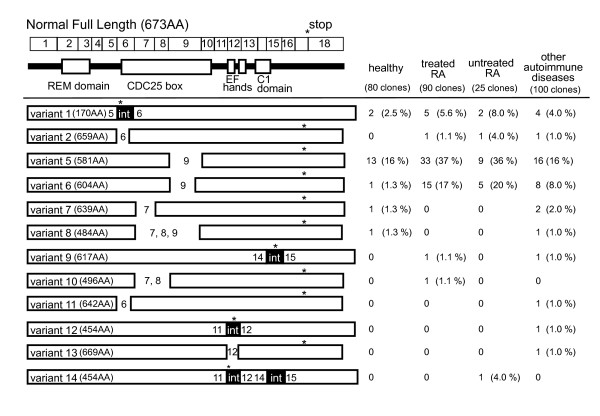
Novel transcripts that encode abnormal hRasGRP4 isoforms in the PBMCs. The top panel shows the exon structure and corresponding functional motifs of hRasGRP4, which include the Ras exchange motif (REM), CDC25-like GEF domain (CDC25 box), calcium-binding EF hands, and diacylglycerol -binding C1 domain. Splice variants 5 to 14 in the lower panel correspond to the 10 new hRasGRP4 transcripts identified in our RA patients. If translated, the number of amino acids (AA) in each expressed isoform is indicated. Eighty hRasGRP4-specific cDNAs were isolated and sequenced from 16 healthy individuals. Two, 13, 1, 1 and 1 of these cDNAs corresponded to splice variants 1, 5, 6, 7, and 8 respectively. The remaining 62 sequenced cDNAs in this control group corresponded to the normal, full-length hRasGRP4 isoform. Ninety and 25 hRasGRP4-specific cDNAs were isolated and sequenced from 18 RA patients undergoing treatment and from five untreated RA patients, respectively. The type and number of the identified defective transcripts in these patients are shown. One hundred hRasGRP4 cDNAs from 20 patients with other autoimmune diseases were sequenced, resulting in 36 defective and 64 normal hRasGRP4 transcripts as shown. Variants 1, 9, 12, and 14 possess a premature translation-termination codon (*). Intron 1 is 3.9 kb and many of the other introns in this approximately 17.2 kb human gene are > 1 kb. Because the PCR approach used to identify and quantitate the new isoforms would miss an isoform that contains intron 1, it is likely that additional splice variants exist in PBMCs that contain one or more large introns.